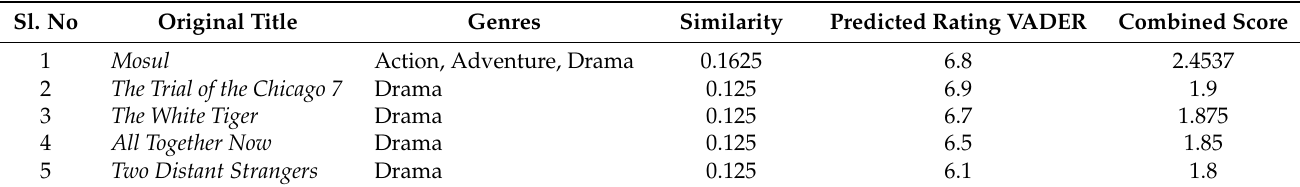
Table 13. Similar movies to the movie Lawrence of Arabia .